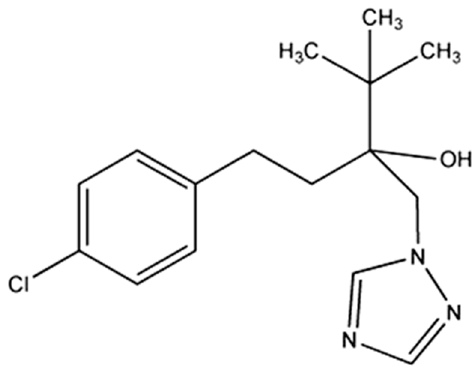
Figure 1. Chemical structure of TBZ.